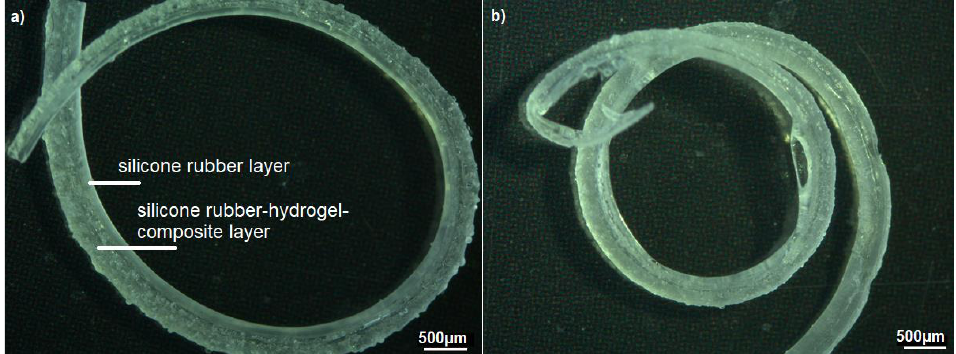
Figure 11. Optical microscopy images of two samples of design C manufactured with Nusil Med 4850-PAMAA (20 wt% hydrogel particles; grain-size fraction 48 µm) deposited on Nusil Med 4850 as a substrate. Samples are shown after ( a ) 168 h and ( b ) 336 h in Ringer solution.